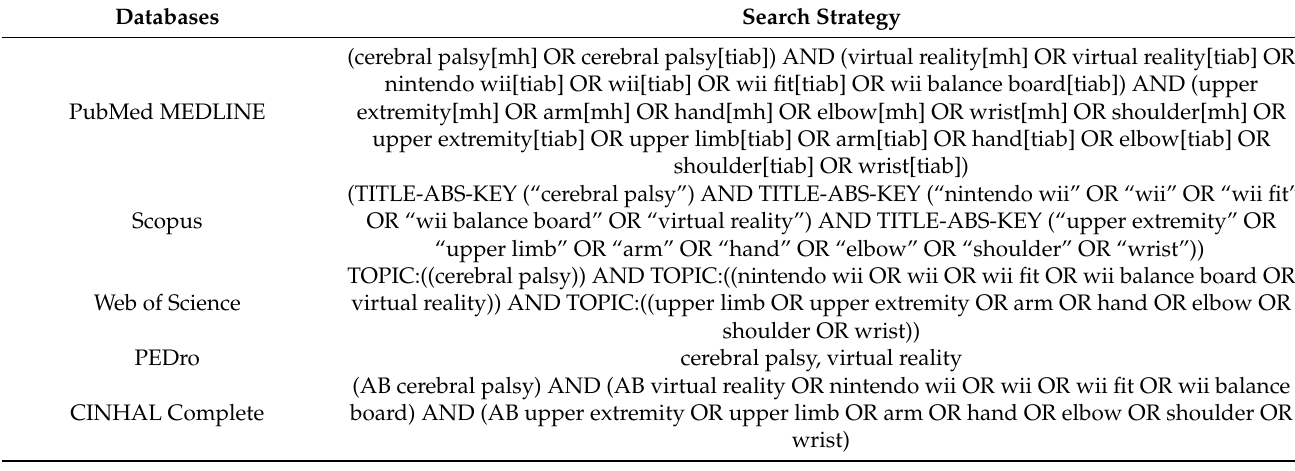
Table 1. Bibliographical searches in each